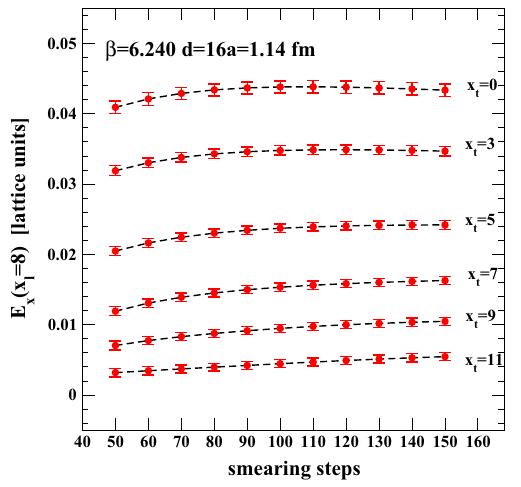
Fig. 6 E x in lattice units versus smearing at β = 6 . 240, d = 1 . 14 fm, measured at the midpoint between sources ( x l = 8 a ), for several values of x t (in lattice units)